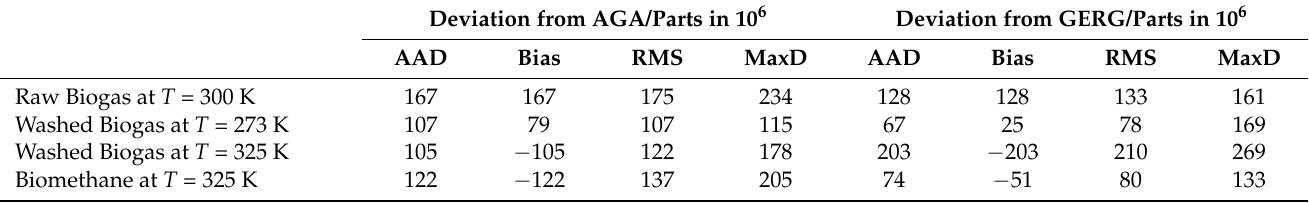
Table 4. Statistical parameters for the comparison between the experimental values of the speed of sound and those calculated with the AGA8-DC92 and GERG-2008 equations of state. Deviation from AGA/Parts in 10 6 Deviation from GERG/Parts in 10 6 AAD Bias RMS MaxD AAD Bias RMS MaxD Raw Biogas at T = 300